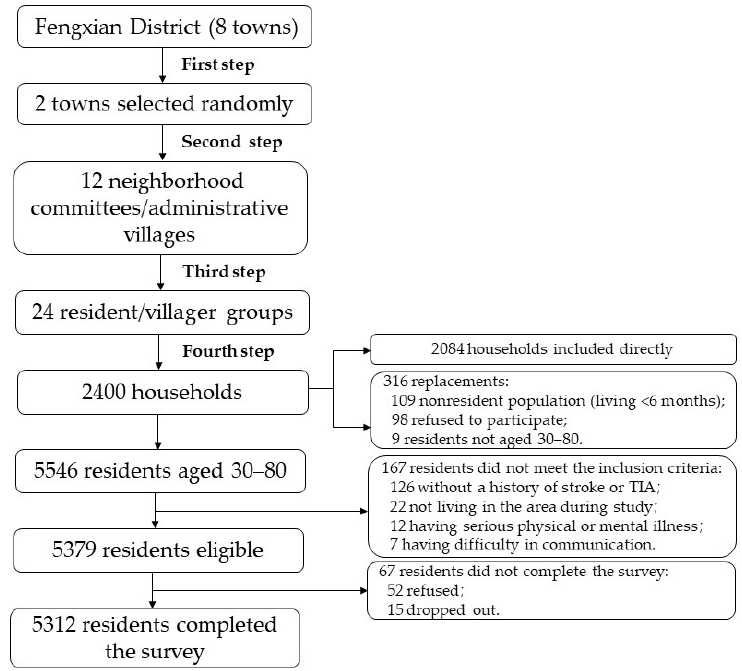
Figure 1. Flowchart of sampling